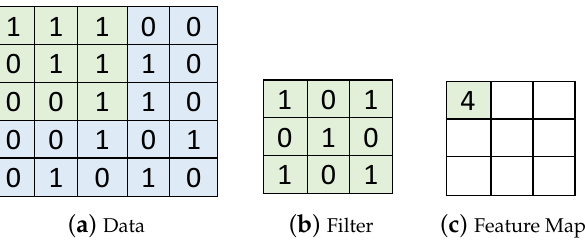
Figure 3. An Example of Convolution using a 3 × 3 Kernel in Deep Learning. In deep learning, convolution consists of element-wise multiplications between the input data and filter as well as the summation of the multiplication results. In this specific example, element-wise multiplications between the data in ( a ) and the filter in ( b ) are performed and summed up to produce the output 4 in ( c ). The filter slides through the data to produce the nine results in ( c ). In this example, the stride is 1; that is, the filter slides by one position to the right or down after completing each convolution operation describe above.